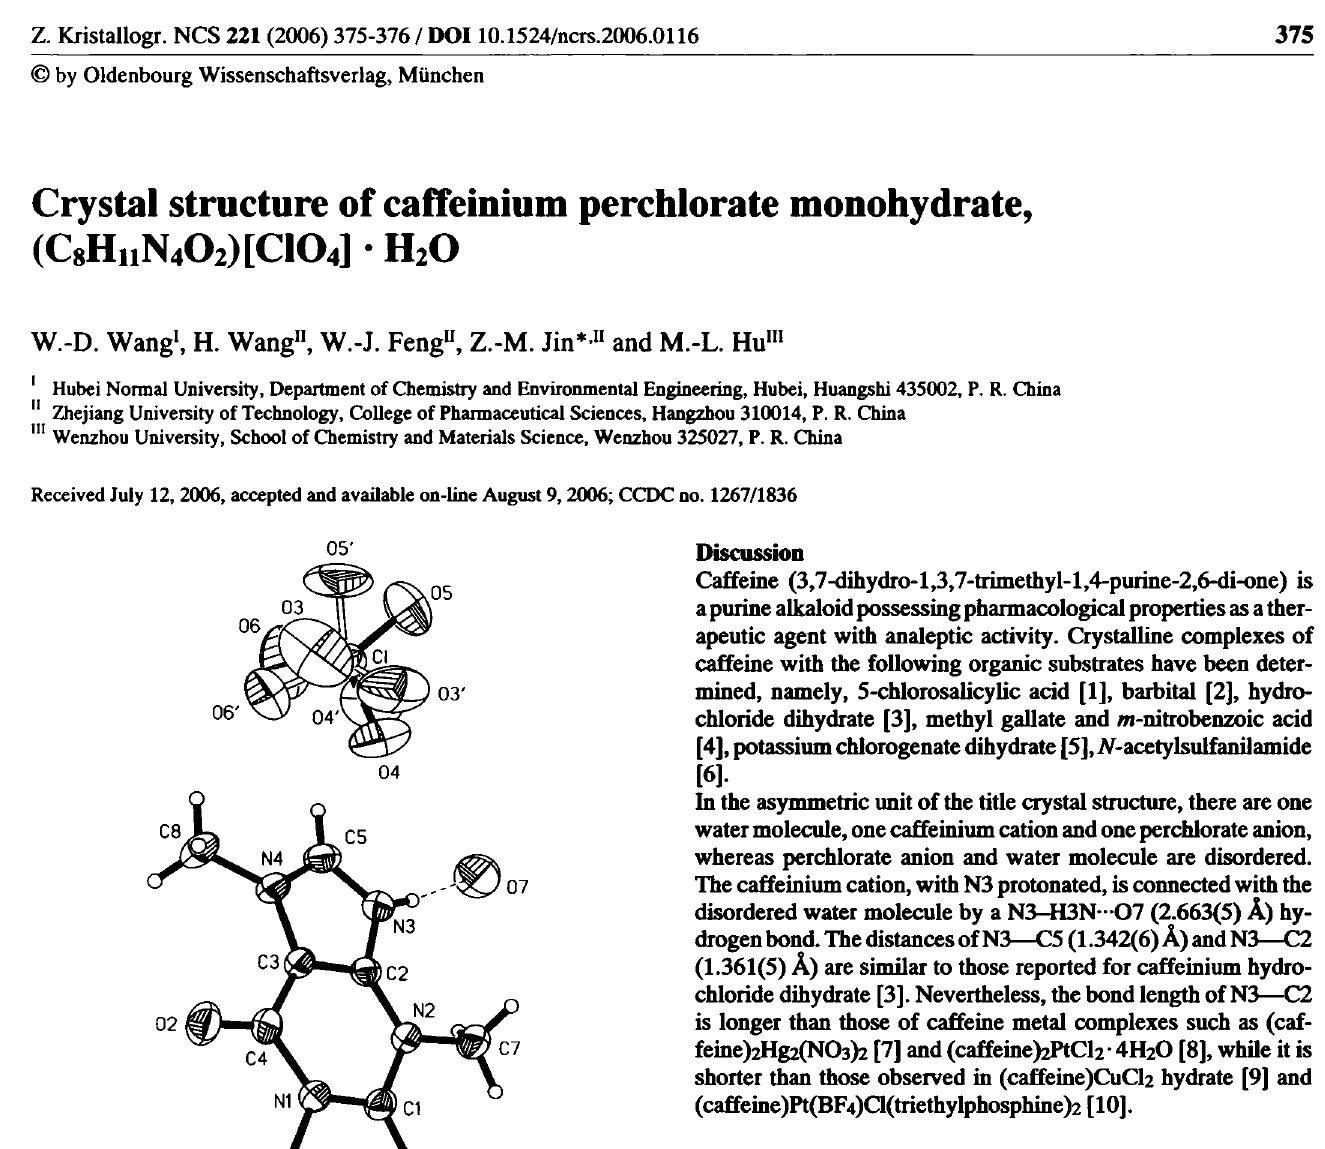
Table 1. Data collection and handling.